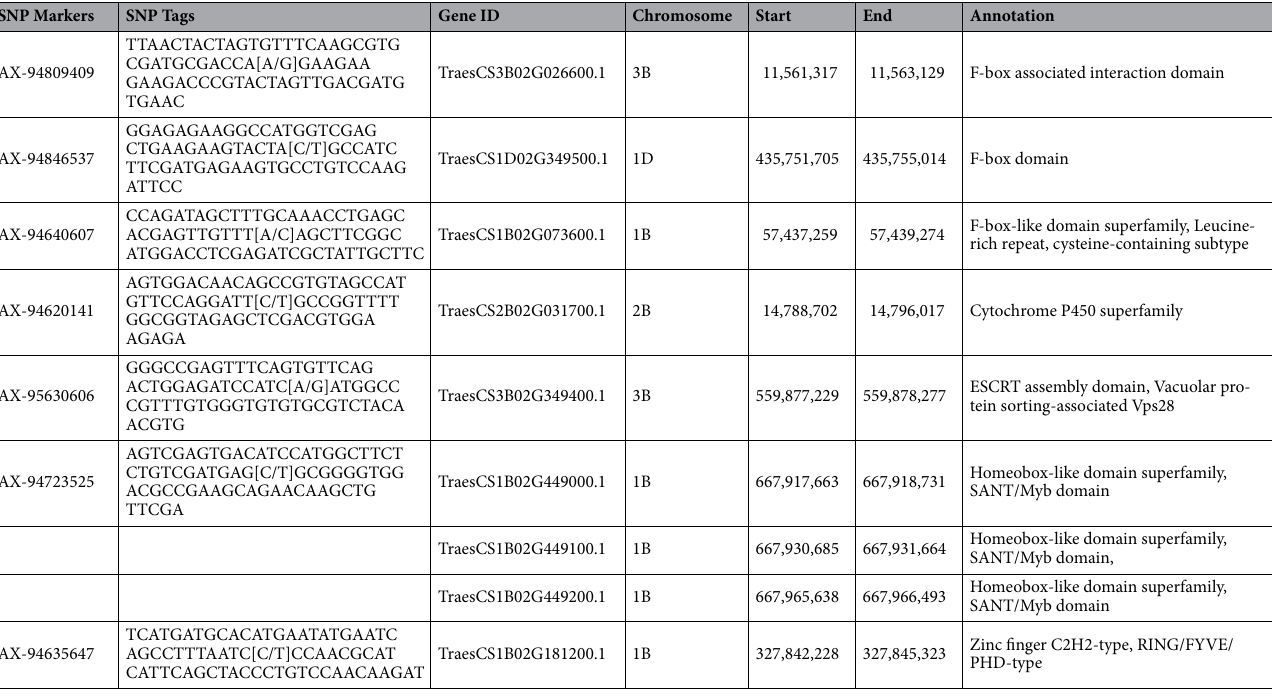
Table 2. Details of disease related candidate gene showing putative associations with P. thornei resistance in